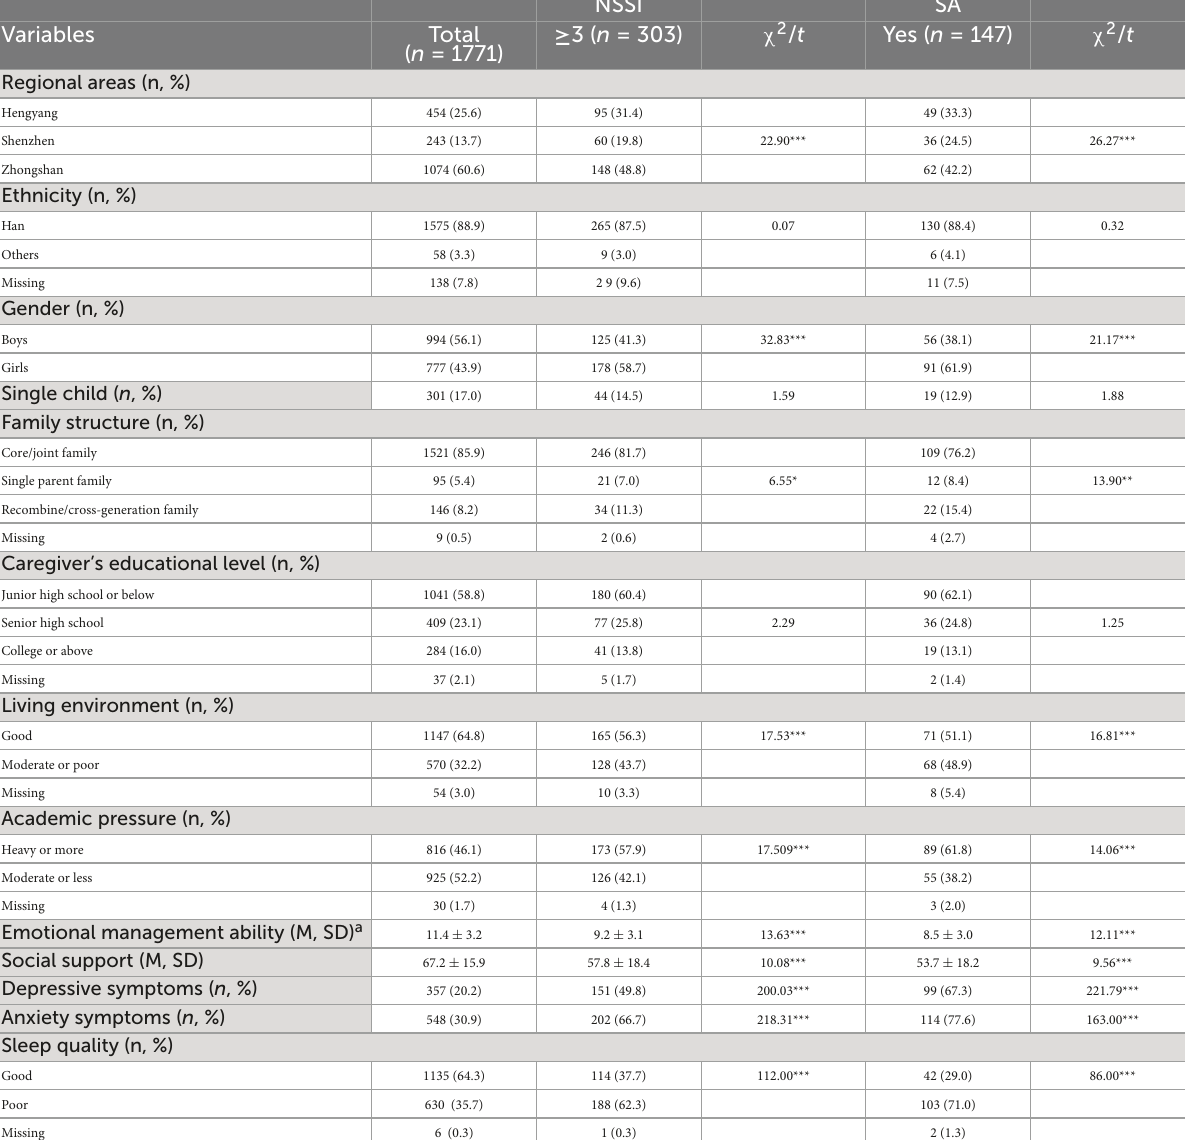
TABLE 1 Characteristics of participants by NSSI or